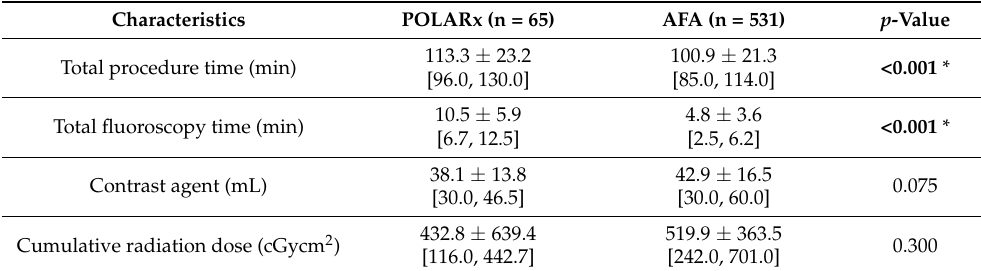
Table 3. Procedural